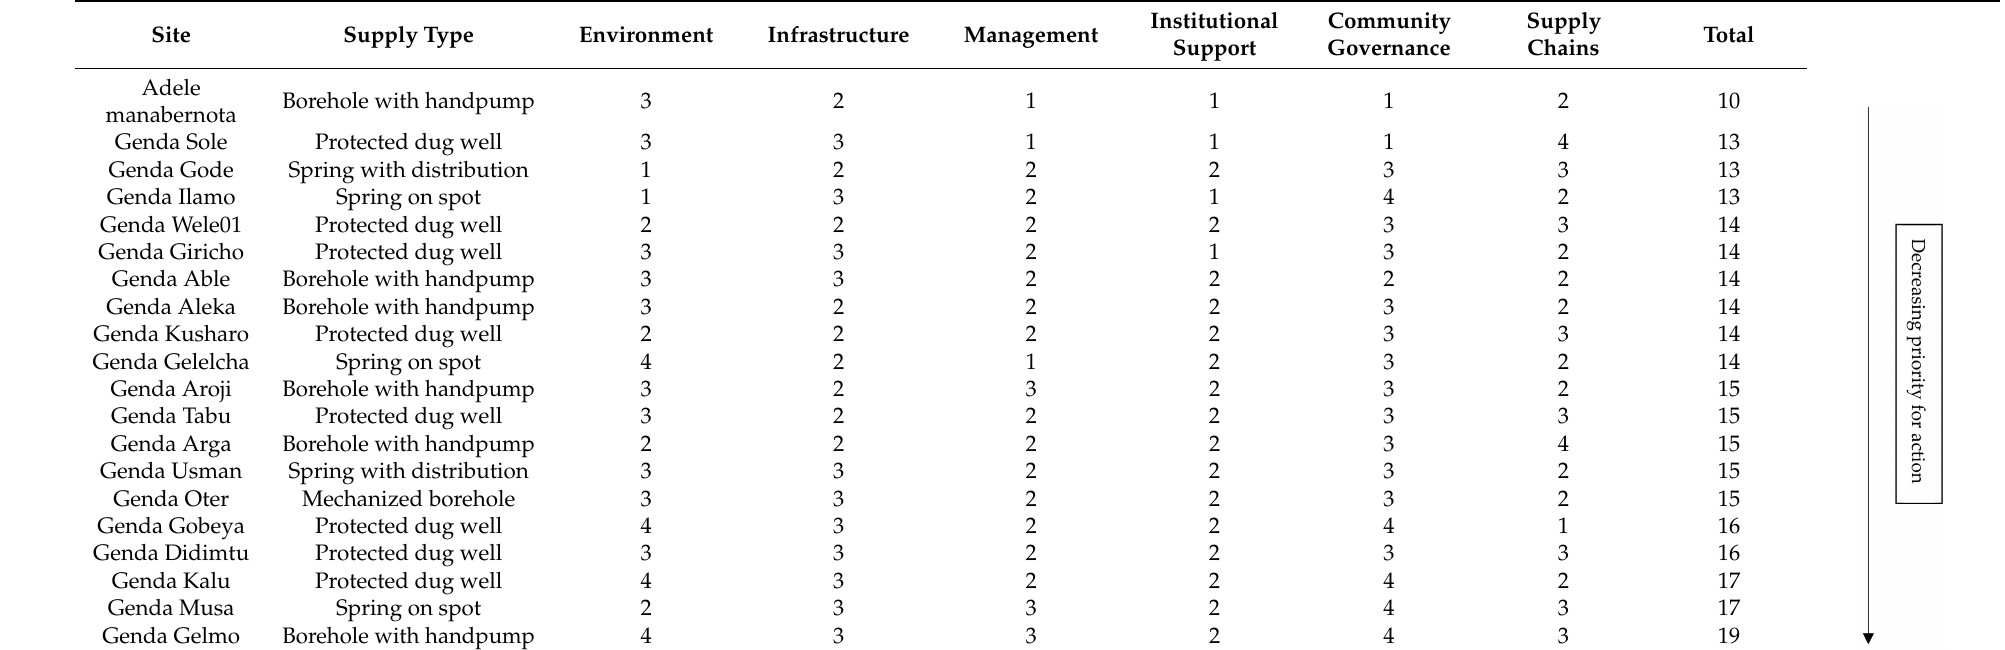
Table 4. Indicator scores for water supplies in